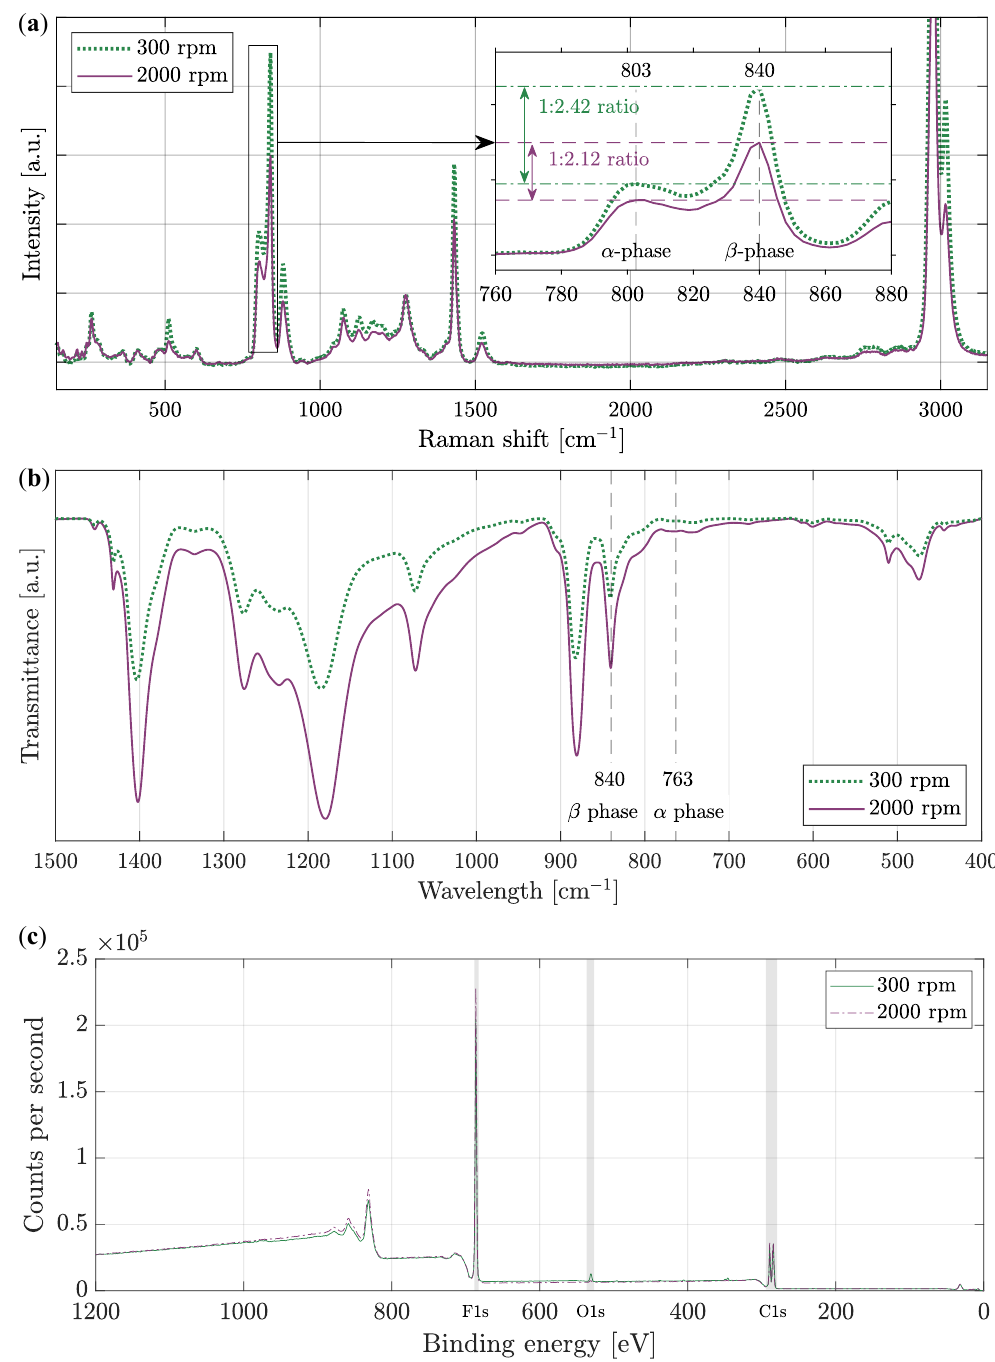
Figure 7. Nanofiber PVDF material investigated using ( a ) the Raman spectroscopy with focus to 760cm − 1 to 880cm − 1 region. ( b ) FTIR transmittance spectra with emerging phases α and β , indicated by a dashed line. ( c ) XPS wide spectra of PVDF nanofibers, for both types PVDF electrostatically spun at 300rpm and 2000rpm collector